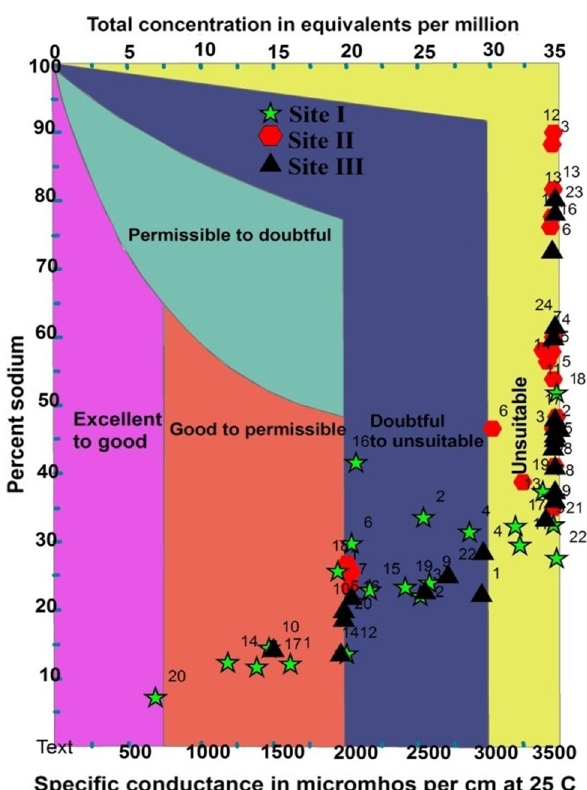
Fig. 4 Wilcox (1955) diagram in the study area